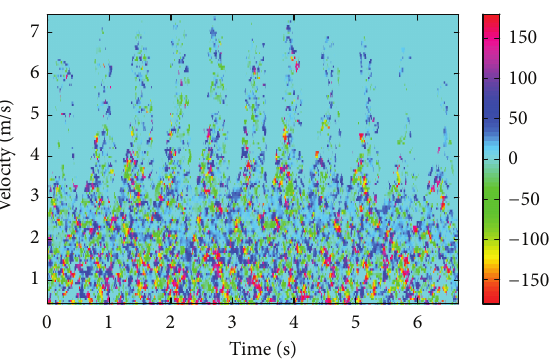
Figure 6: Polarimetric measurement of a loaded human walking toward the radar at Ka band. The red (and yellow) double-bounce areas correspond to the elbow motion, while the blue (and green) single bounce is the rest of the body. Comparison with Figure 2 shows a reduction in the arm